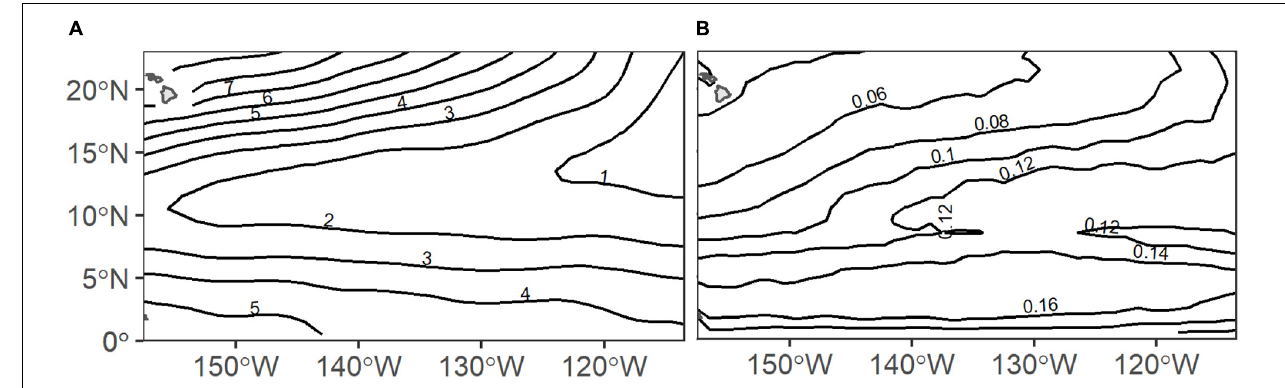
FIGURE 1 | Annual climatologies of (A) midwater oxygen partial pressure (pO 2 ; kPa) and (B) surface chlorophyll (chl- a ; mg m − 3 ) across the eastern Central Pacific Ocean (source details in Table 1 ).